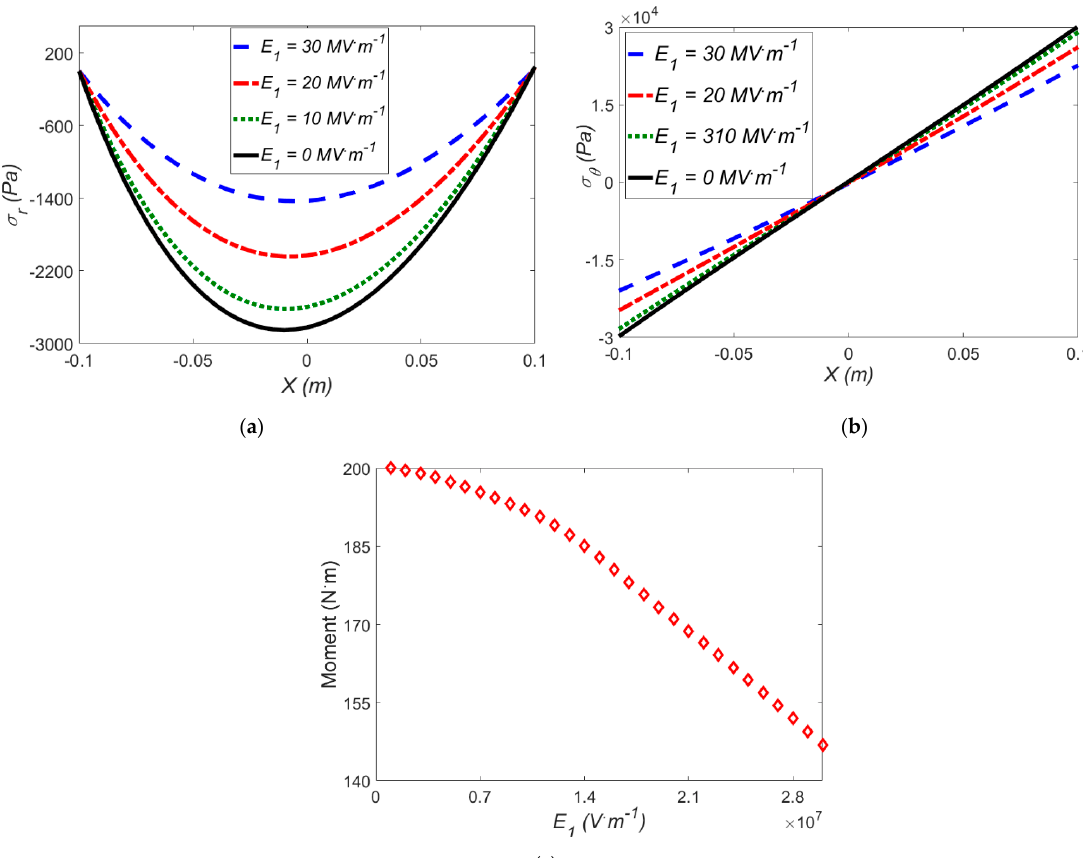
Figure 6. The effect of the electric field on ( a ) radial stress; ( b ) hoop stress; ( c ) induced moment for Mooney-Rivlin model with ρ = 0.5 m in the absence of temperature